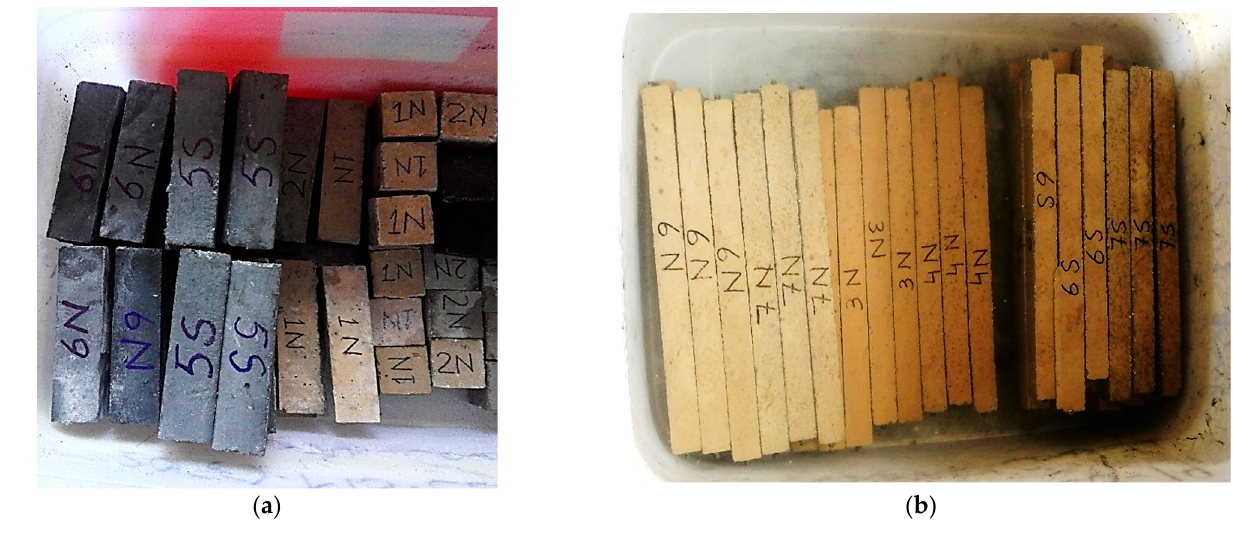
Figure 1. Specimens prepared ( a ) mortar cubes (50 × 50 × 50 mm) and prisms (40 × 40 × 160 mm) ( b ) mortar bars (25 × 25 × 285 mm).